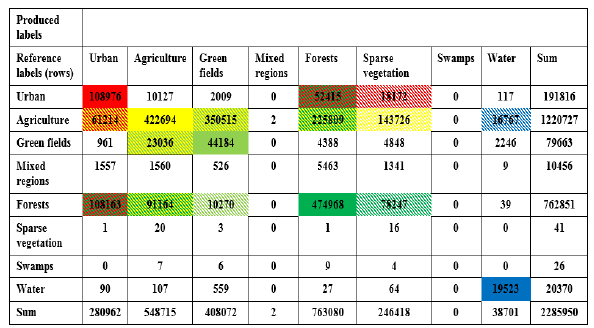
Table 3. Covariance matrix for the supervised land cover classification